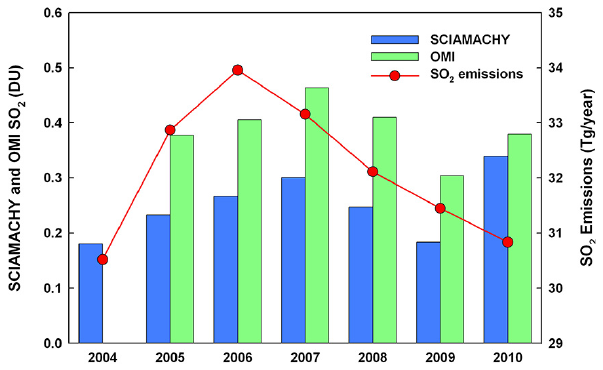
Fig. 12. SO 2 emissions in China and annual average SO 2 column from SCIAMACHY and OMI over eastern central China during 2004–2010.